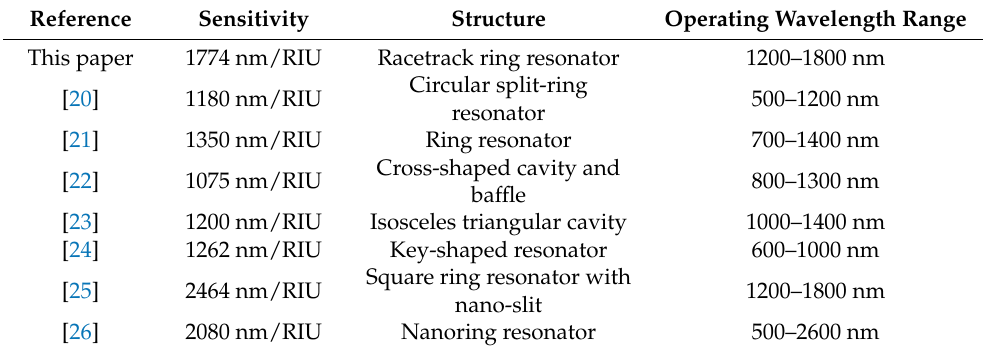
Figure 6. ( a ) Transmission spectra of the refractive indices ranging from 1.00 to 1.05 RIU. ( b ) Lin- ear fitting of the sensitivity.